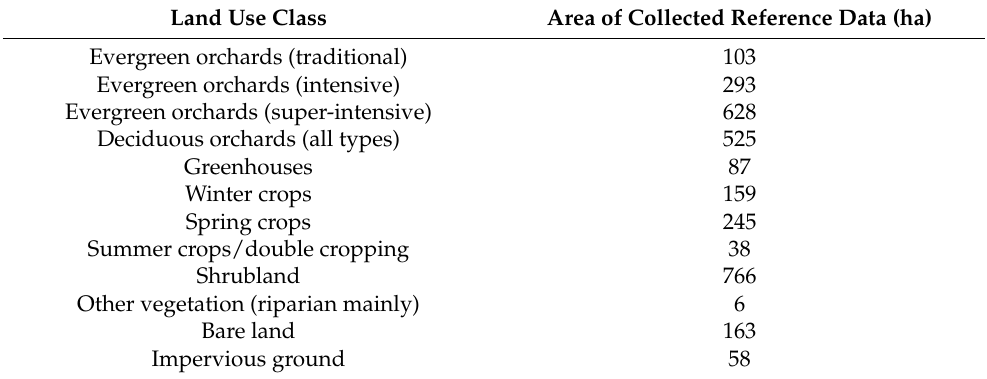
Table 4. Land use class definitions based on the highest NDVI month (annual crops) and bi-temporal photointerpretation (orchards) and per class areas sampled.